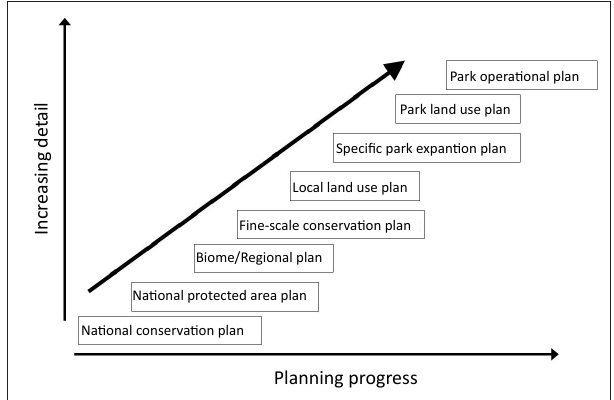
FIGURE 3: Theoretical progression of nested systematic conservation planning processes.